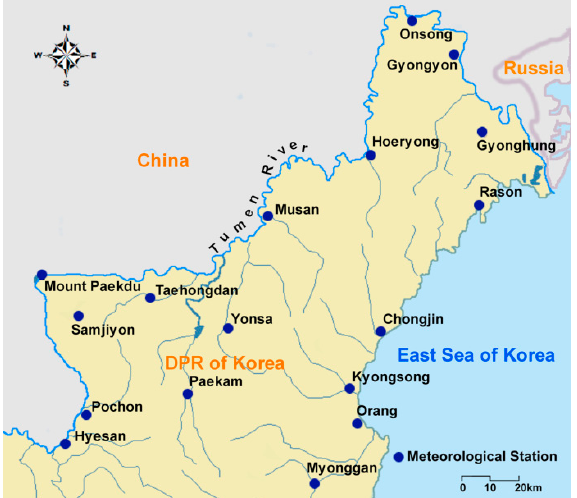
Figure 3. Network of meteorological stations (the northern area in DPR Korea).